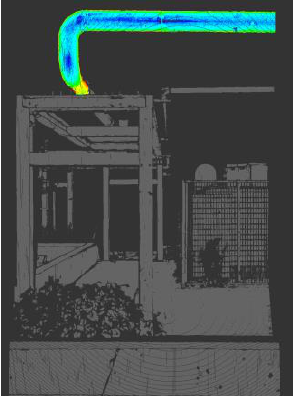
Figure 4. Intensity image of a pipe. Blue points indicate a stronger intensity than red points.